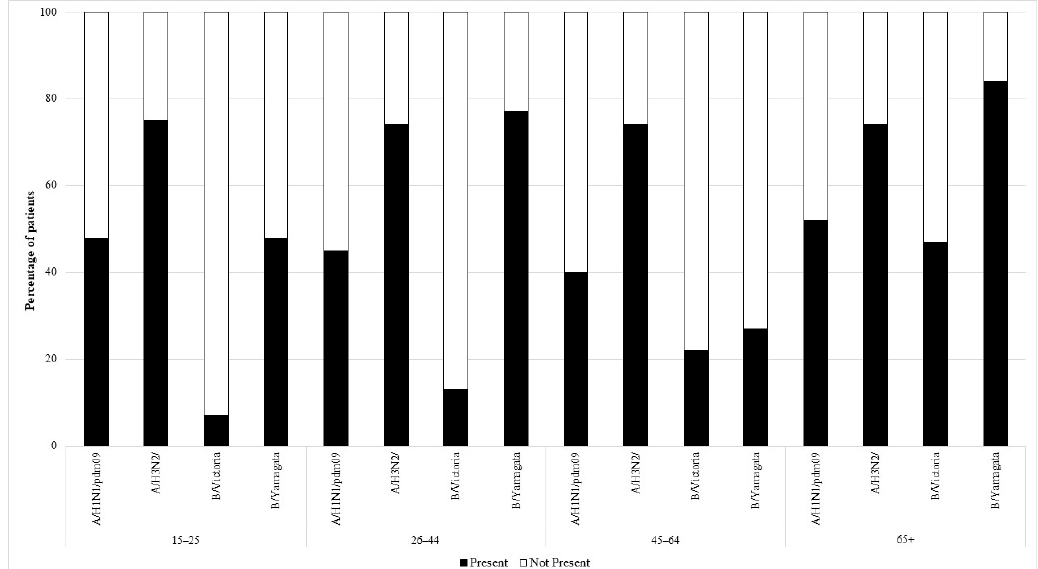
Figure 2. The presence of antibodies in the serum of patients aged 15–25, 26–44, 45–64, and 65+ years of age in the 2019/2020 epidemic season.